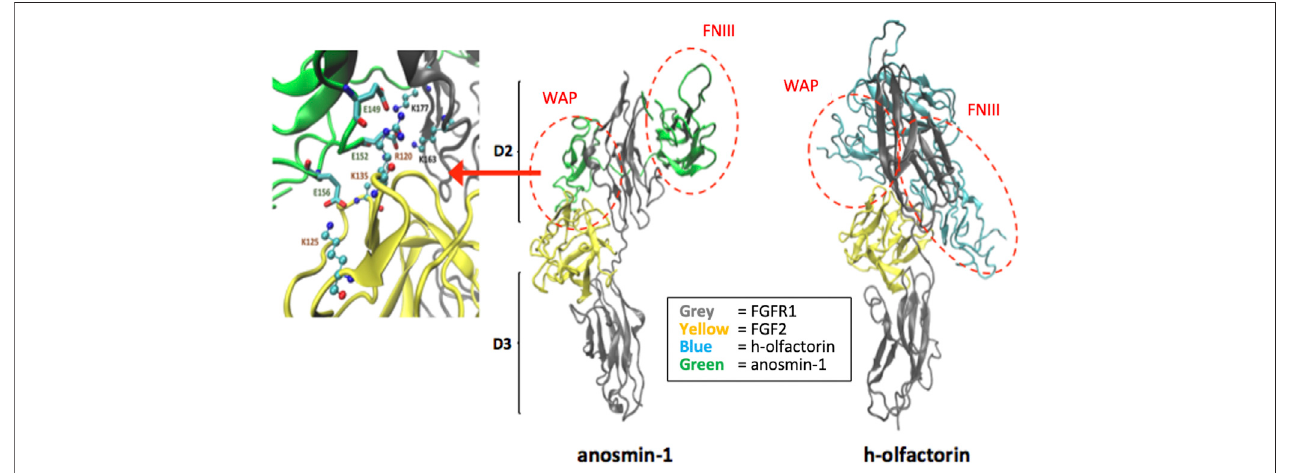
FIGURE7| PotentialinteractionbetweenthemodeledhumanolfactorinstructureswiththeresolvedFGFR1-FGF2complex(PDBcode:1FQ9)anditscomparison with anosmin-1. As evidenced (red circles) WAP domains of olfactorin and anosmin-1 interact with the D2 domain of FGFR1 by assuming comparable arrangements. Greater differences are seen in the pose of the FNIII.1 domain; however, in both complexes it appears to conveniently approach the D2 domain of FGFR1. As shown in the left panel, the WAP-FGFR1 interactions appear to be mostly stabilized by ionic